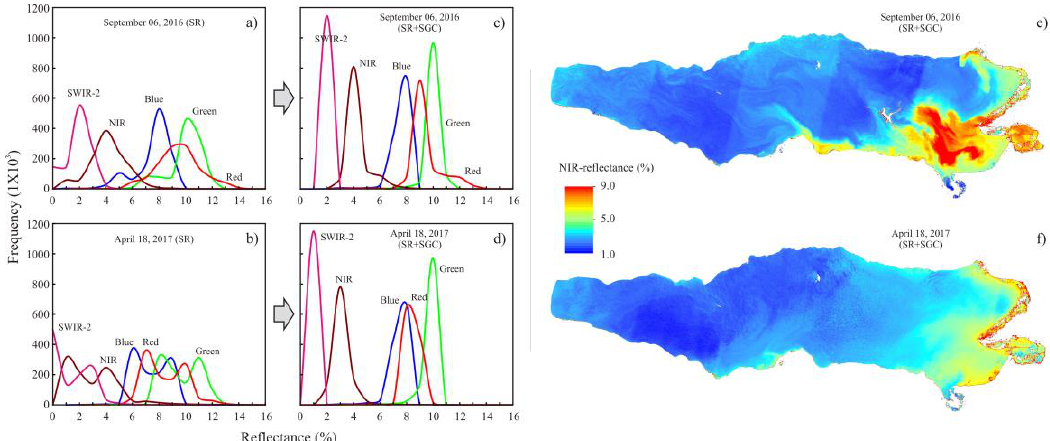
Figure 6. Spectral histograms of the VIS-NIR-SWIR surface reflectance from Landsat-8: ( a ) corresponds to 6 September 2016, ( b ) corresponds to 18 April 2017. Histograms after the sun-glint correction (SGC) procedure: ( c ) for image taken on 6 September 2016 and ( d ) for image taken on 18 April 2017; water-leaving reflectance after the SGC: ( e ) 6 September 2016, and ( f ) corresponds to 18 April 2017.